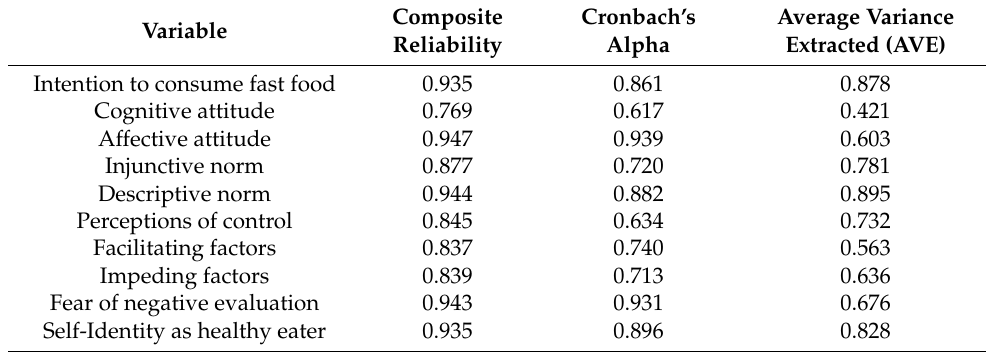
Table 3. The reliability of